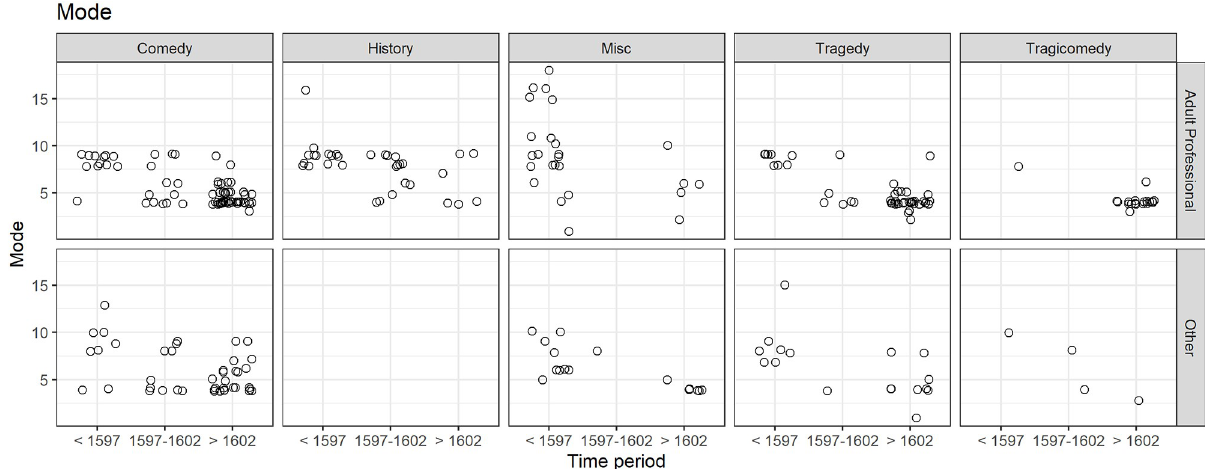
Fig 8. (S1 Fig 9 in S1 File) Mode of speech length (with jittering) by genre, play type and time groups.